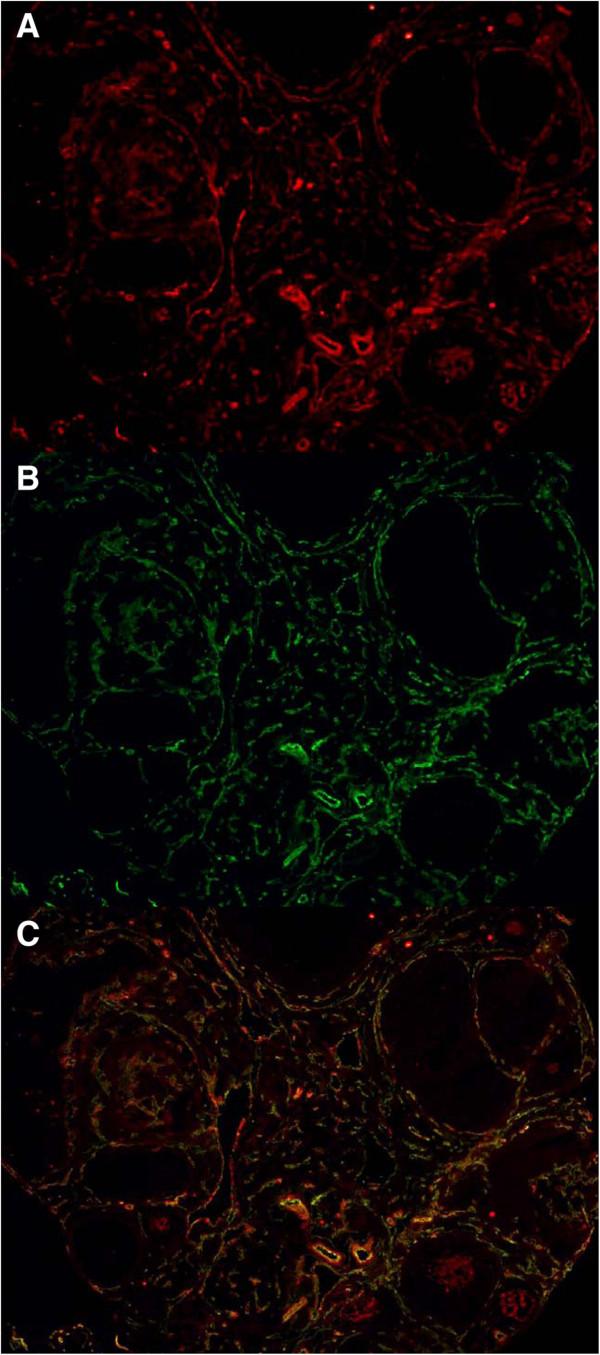
PMSG stimulated untreated ovary with tertiary follicles: A) Notch3 in red B) PECAM in green C) Composite image with overlapping areas in yellow. Please note presence of Notch3 staining in the peripheral theca layer and absence of Notch3 staining on granulosa cells. (10× magnification).